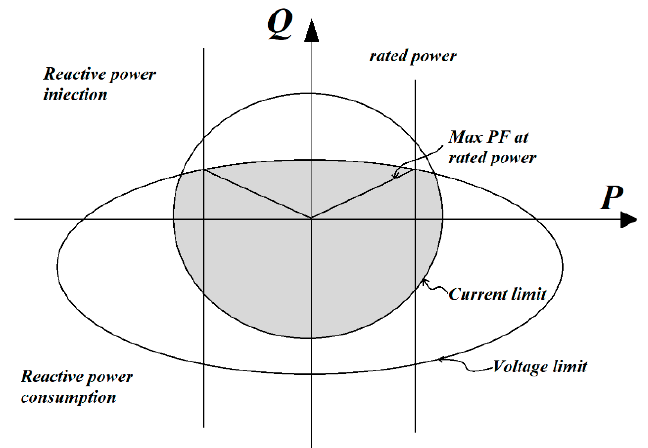
Figure 2. Inverter active and reactive power limits.